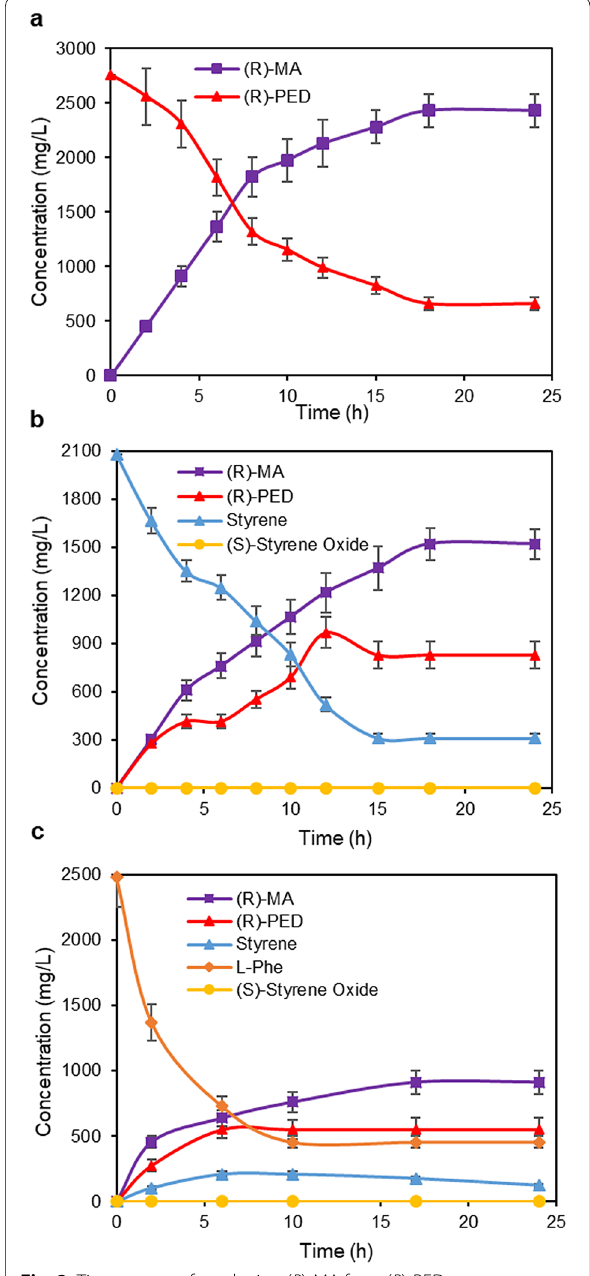
Fig. 2 Time course of producing ( R )-MA from ( R )-PED, styrene, and L- phenylalanine. a Biotransformation of ( R )-PED to ( R )-MA with E. coli (AldO) cells (15 g cdw/L) in KP buffer (200 mM, pH 8.0). b Biotransformation of styrene to ( R )-MA with E. coli (S2A) cells (15 g cdw/L) in a mixture of KP buffer and n- hexadecane (1:1; v/v). c Biotransformation of L -Phe to ( R )-MA with E. coli (P2S2A) cells (15 g cdw/L) in a mixture of KP buffer and n- hexadecane (1:1; v/v). All reactions were performed at 30 °C and 250